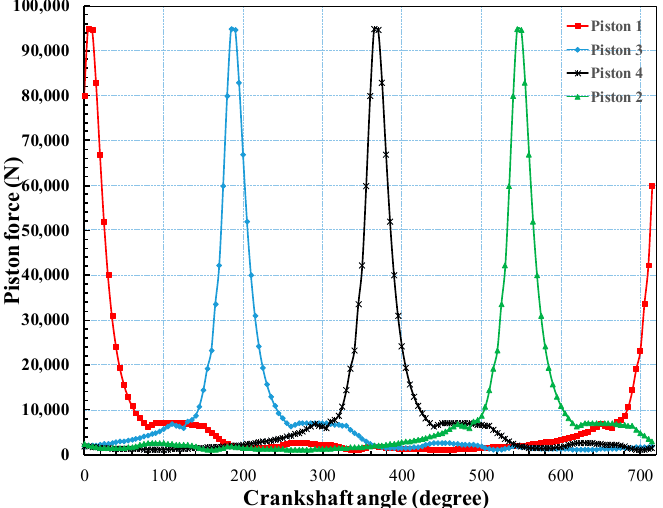
Figure 4. The modelled forces on the piston.